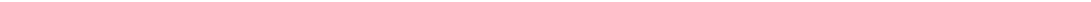
Figure 1 | AC-1 inhibits Kv7.1 channels only in the presence of KCNE1. ( a ) Structure of adamantane compound AC-1. ( b ) Concentration-response relationship for inhibition of Kv7.1/KCNE channel currents by AC-1. Kv7.1/KCNE1 channel currents were activated by repetitive 7s pulses to þ 40mV applied from a holding potential of (cid:2) 80mV. Inhibition was determined as percent change in current amplitude at the end of the depolarizing test pulse to þ 40mV. Data were fitted (smooth curve) to the Hill equation ( n ¼ 5–70, ± s.e.m.). ( c ) The inhibitory effect of different AC-1 concentrations on Kv7.1/KCNE1 channels was determined by repetitive 7s pulses to þ 40mV applied from a holding potential of (cid:2) 80mV. Current amplitudes at the end of the depolarizing test pulse were normalized to initial values and plotted against time ( n ¼ 3–5, ± s.e.m.). ( d ) The onset of inhibition was described using a single exponential function and the time constant t inhibition was plotted against the respective AC-1 concentration. This relationship could be described using a linear function with m ¼ (cid:2) 1.02 ± 0.19 ( n ¼ 3–5, ± s.e.m.). ( e ) Lack of 1 m M AC-1 inhibition of Kv7.1, Kv7.1/KCNE2–5, Kv7.2 and Kv1.5. ( f ) Lack of effect of different AC-1 concentrations on Kv7.1 homotetramers ( n ¼ 3–5, ± s.e.m.). Example of homomeric Kv7.1 channel currents before (black) and after application (grey) of 10 m M AC-1 shown in the inlay. Currents were elicited by 7s test pulses to þ 40mV (scale bars indicate 1 m A, 1s). ( g ) Inhibitory effects of 3 m M AC-1 on Kv7.1/KCNE1 channels is dependent on the level of KCNE1 expression. Currents were elicited as described in panel c (scale bars indicate 2 m A, 2s). ( h ) The effect of variable KCNE1 expression on the sensitivity of Kv7.1 channels to three concentrations of AC-1. Inhibition of current was determined as described above and plotted against the amount (in ng) of cRNA injected into individual oocytes. Relationships were fitted using the Hill equation (smooth curves, n ¼ 3, ±